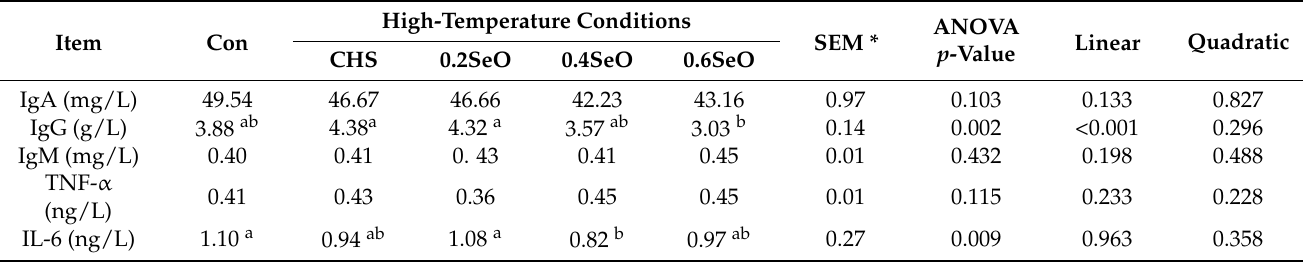
Table 1. Effects of CHS and SeO supplementation on serum immunoglobulin and inflammatory factors of growing pigs.